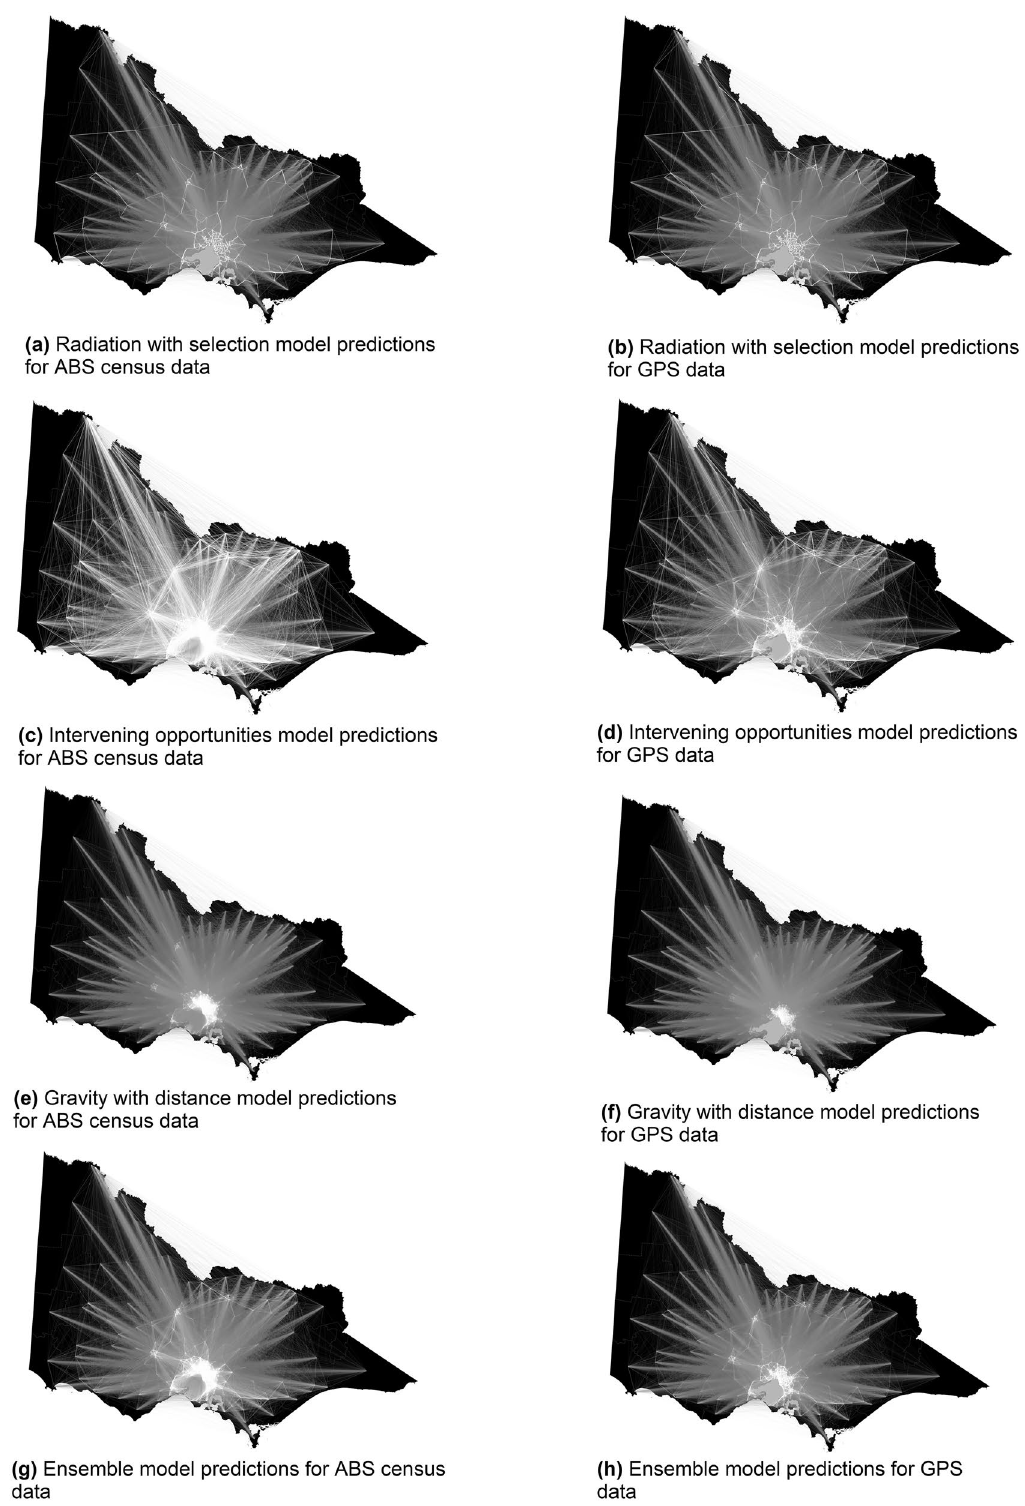
Figure 3. Range and intensity of interaction in Victoria revealed through different model types using the ABS census journey to work data (left column) and GPS data (right column). Movement predictions from each model were scaled to be between 0 and 1 to aid visual comparison. This range is mapped to line thickness, opacity and brightness (from black to white), where vivid thick white lines represent high intensity movement and low intensity movement is shown via faint thin darker lines. The Gravity and radiation model prediction maps are omitted as they are visually similar to the gravity with distance and radiation with selection model predictions respectively. The maps in this figure were produced using the R 33 package ggplot2 34 (see Visualisation of predictions section in Methods for further detail). Preview 35 and Paint 3D 36 were used to combine the maps into one image and add the